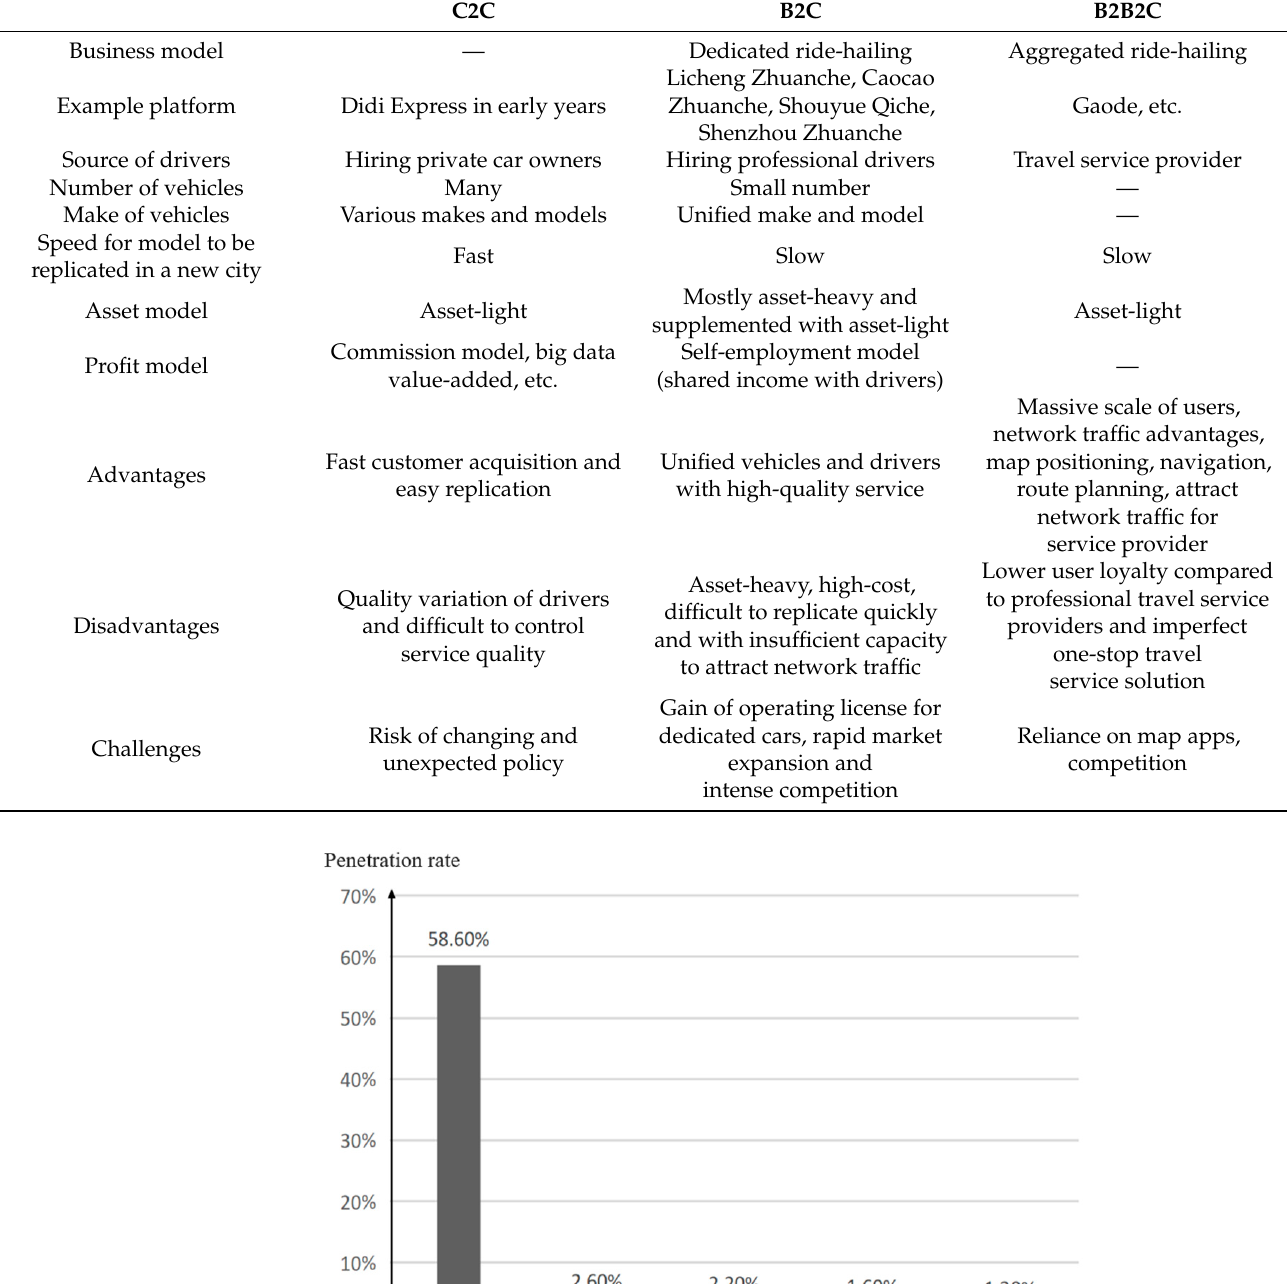
Table 1. Business models of online ride-hailing platforms [32].